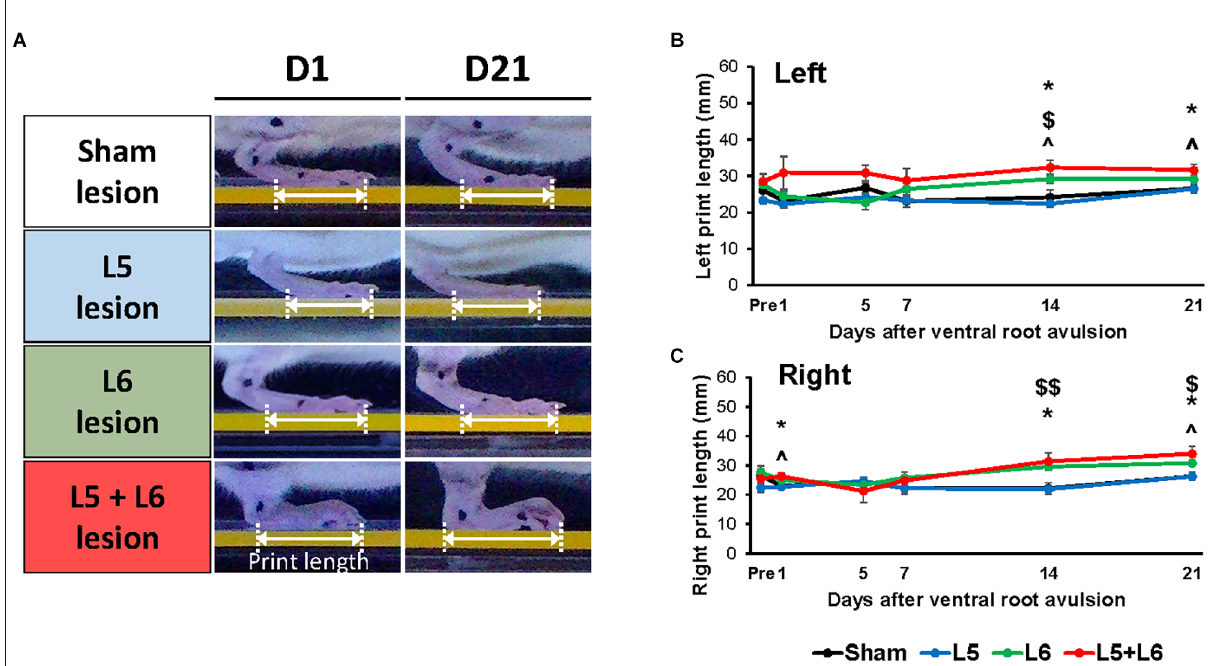
FIGURE5 Characteristics of the stepping footprint during locomotion of post-lesion rats (A) . The time-course changes of print length of the sham and VRA lesion rats in the walkway locomotion test during the 21 days (B,C) . Levels of significance: * p < 0.05, indicated a significant difference between the sham and L5 + L6 groups; ∧ p < 0.05 was used to mark the post hoc LSD difference between L5 + L6 lesion vs. L5 lesion; $ p < 0.05, $$ p < 0.01 were used to mark the post hoc LSD difference between L6 lesion vs. sham lesion group. Data are expressed as the mean ± SEM.